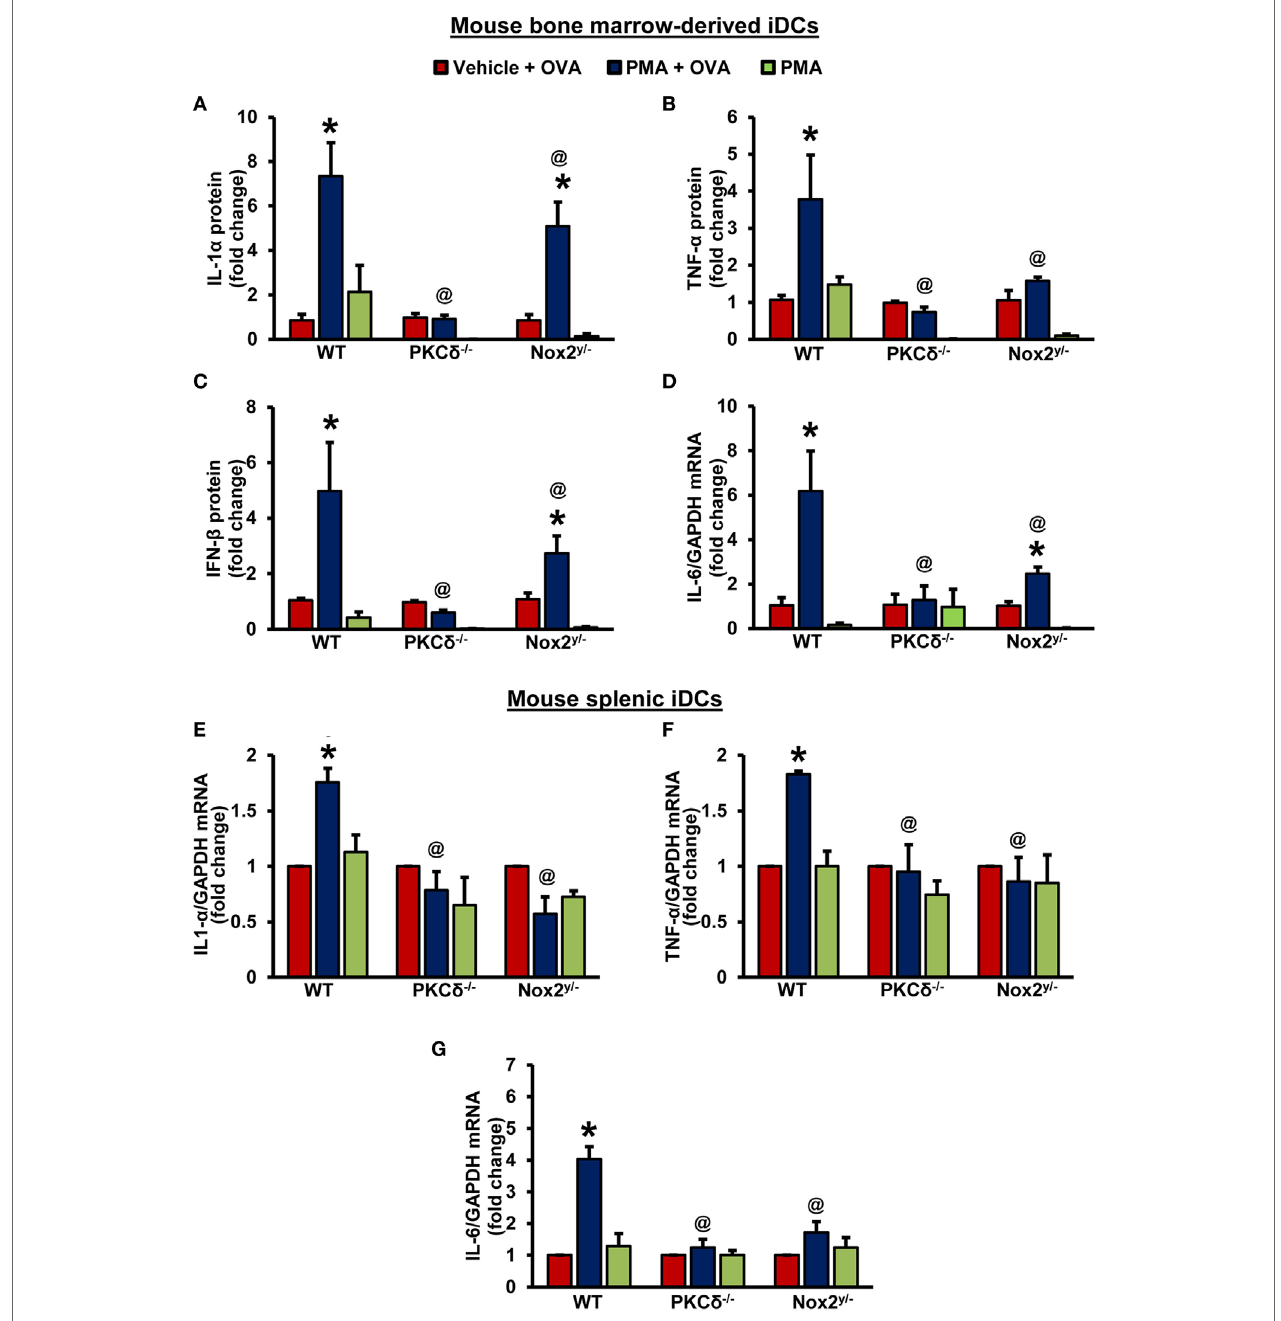
FigUre 5 | PKC δ - and Nox2-mediated antigen macropinocytosis regulates DC secretion of T-cell regulatory cytokines. (a–c) Wild-type (WT) (C57BL/6J), PKC δ − / − and Nox2 y/ − BMiDCs were treated with vehicle or PMA in the presence of unlabeled OVA (50 µg/mL) or PMA alone for 24 h. Cell culture supernatants were collected and levels of secreted cytokines determined using LEGENDplex ™ bead-based immunoassay assay. Bar graphs show fold changes in cytokine secretion compared to “vehicle + OVA” treatment. Data are representative of three independent experiments and values are expressed as mean ± SD. (D) BMiDCs were treated as described above. The mRNA levels of IL-6 were determined by qRT-PCR. Bar graphs show fold change in the expression of IL-6 compared to “vehicle + OVA” treatment ( n = 3) and data represent the mean ± SD. (e–g) WT, PKC δ − / − , and Nox2 y/ − CD11c + splenic iDCs were treated with vehicle + OVA, PMA + OVA, or PMA alone for 24 h. The mRNA levels of cytokines were determined by qRT-PCR. Data are representative of three independent experiments performed in triplicate and represent the mean ± SEM. Bar graphs show fold change in the expression compared to “vehicle + OVA” treatment. * p < 0.05 vs. vehicle + OVA, and @ p < 0.05 vs. WT PMA +